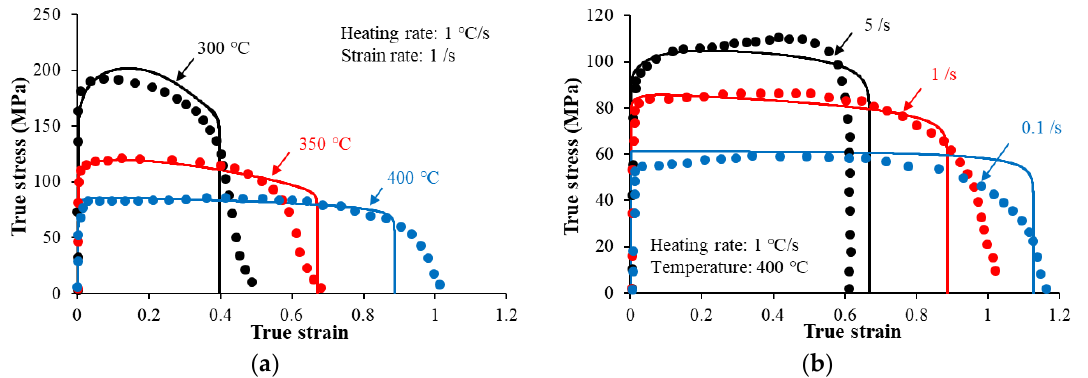
Figure 8. True stress and strain curves of AA7075-T6 heated to ( a ) different temperatures with heating rate of 1/s and ( b ) 400 °C with different strain rates (experimental results: symbols; modeling results: lines).